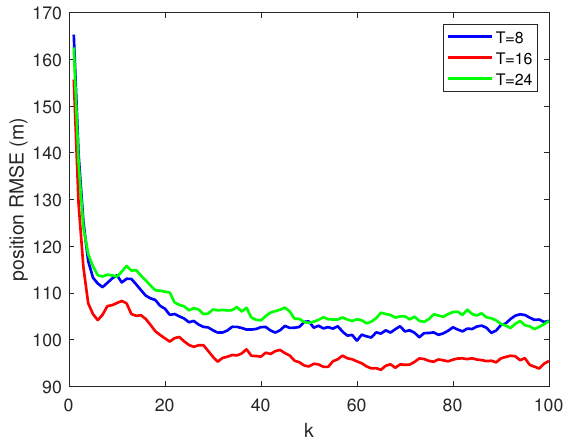
Figure 14. Tracking results of second stage MHT.